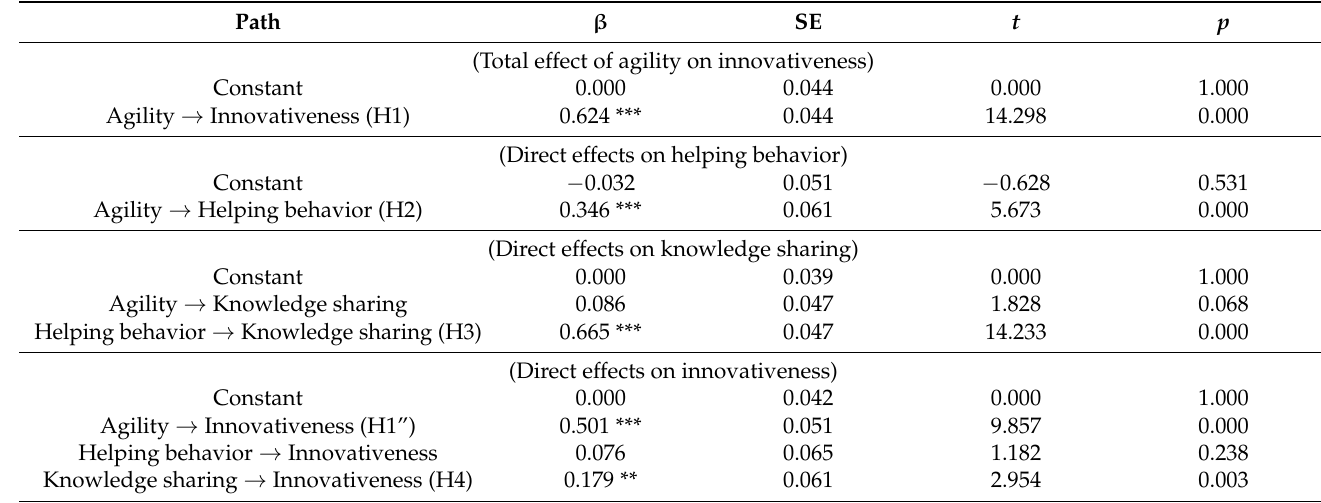
Table 6. Effect by path for ICT companies.